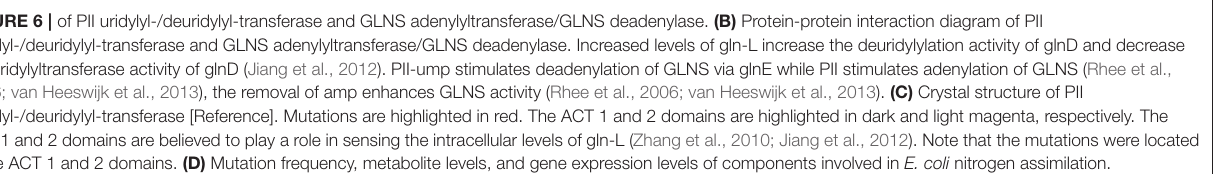
the RNAP binding site (eSdhCB02) and the CysB binding site (eSdhCB03) ( Figure 7A ). cysDNC is positively regulated by the CysB TF. cysD and cysN encode subunits of sulfate adenylyltransferase (SADT2) which converts sulfate (so4) to adenosine 5 ′ -phosphosulfate (aps) ( Figure 7B ). cysC encodes adenylyl-sulfate kinase (ADSK) which converts aps to 3 ′ - phosphoadenylyl-sulfate (paps) ( Figure 7B ). The eSdhCB03 was found to have significantly higher expression levels of cysDNC than all other strains ( Figure 7C